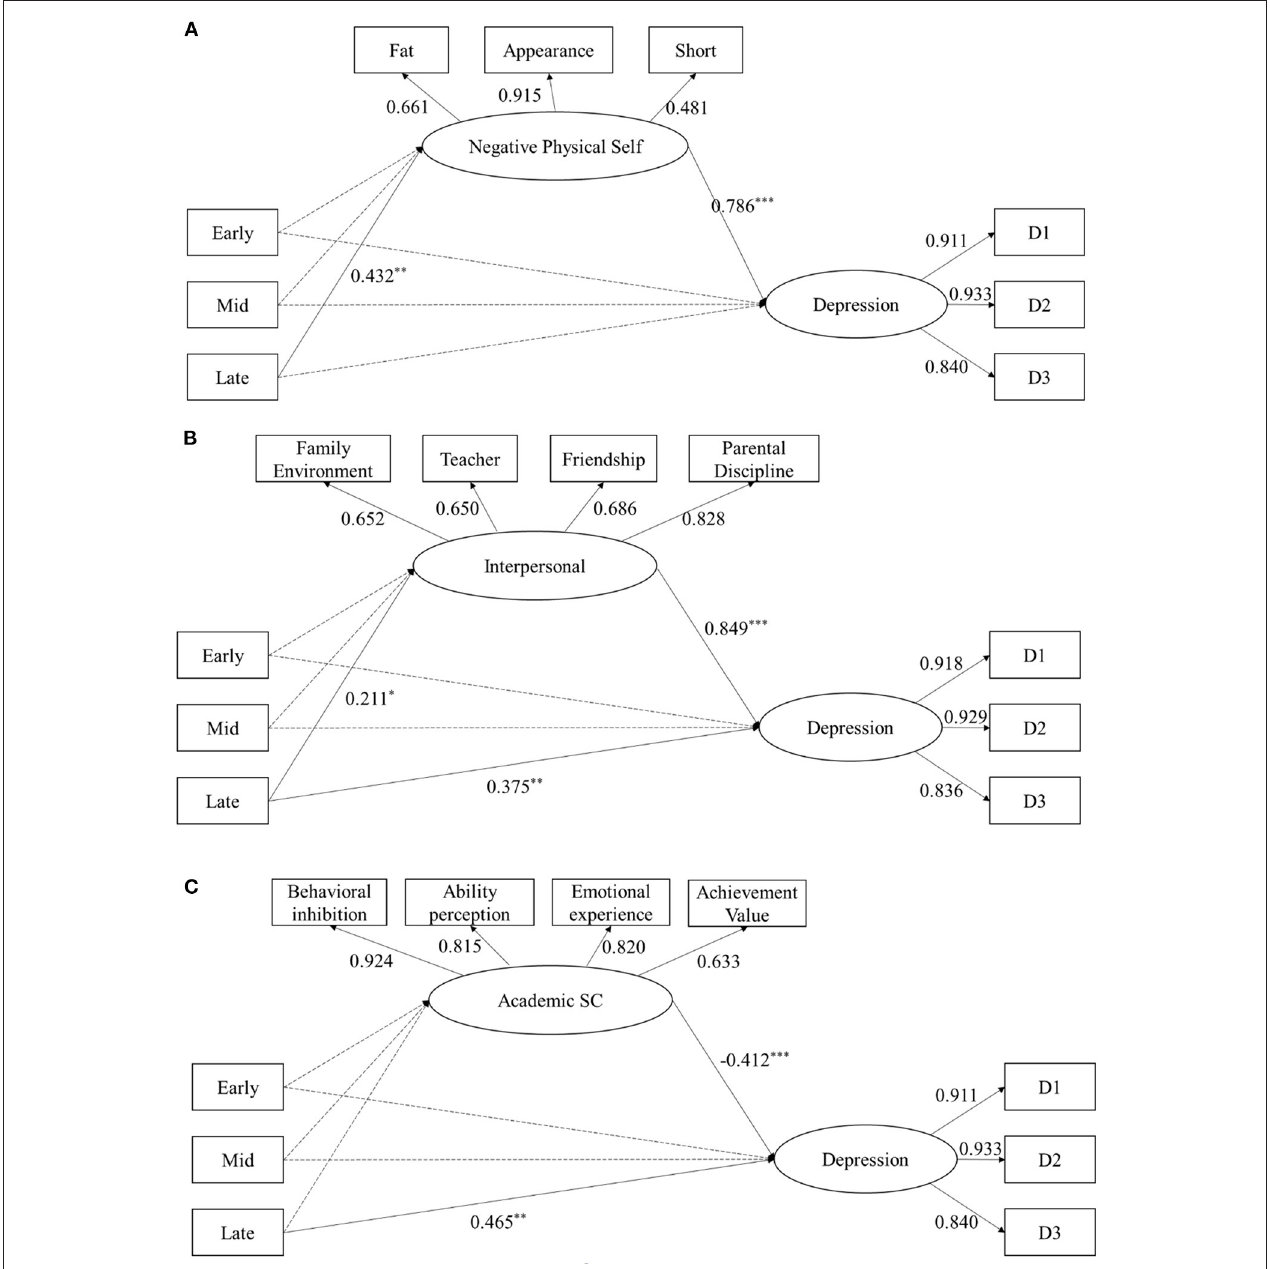
FIGURE 2 | Single factor mediation Model 1, Model 2 and Model 3 were established with negative physical self (A) or interpersonal stress (B) as mediator, respectively. Model 3 was established with academic self (C) as mediator and gender as moderator. Path coefficient was standardized. * p < 0.05, ** p < 0.01, *** p < 0.001, Early, Early puberty; Mid, Mid puberty; Late, Late